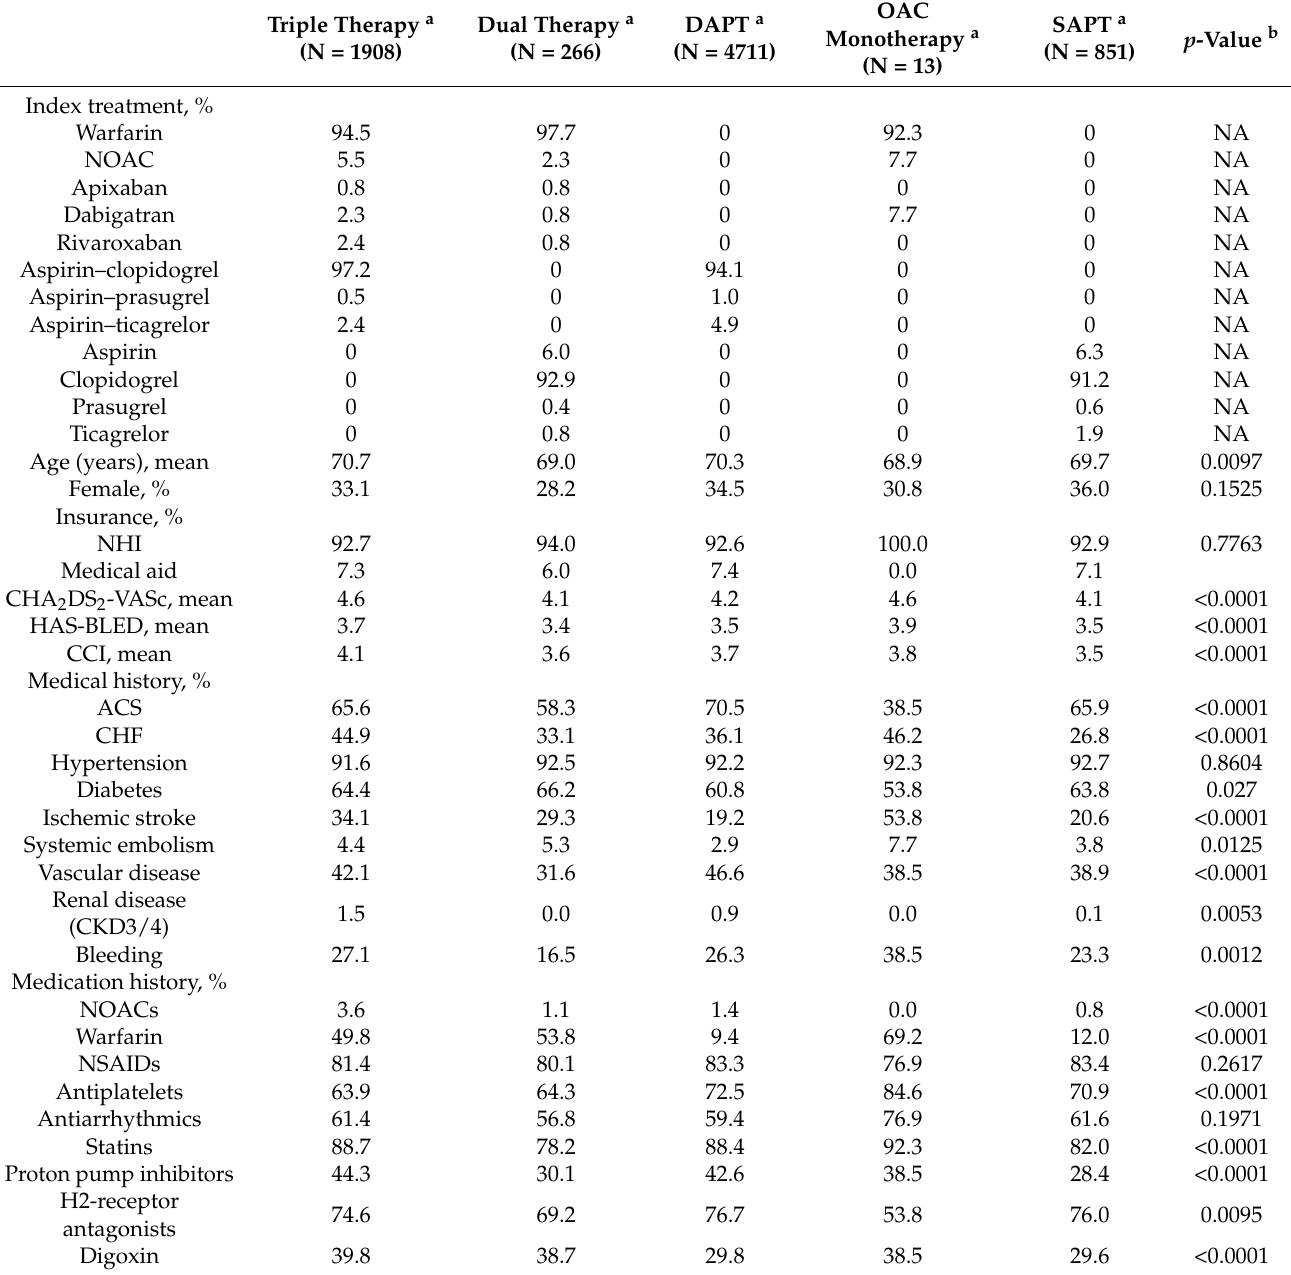
Table 1. Baseline characteristics by index